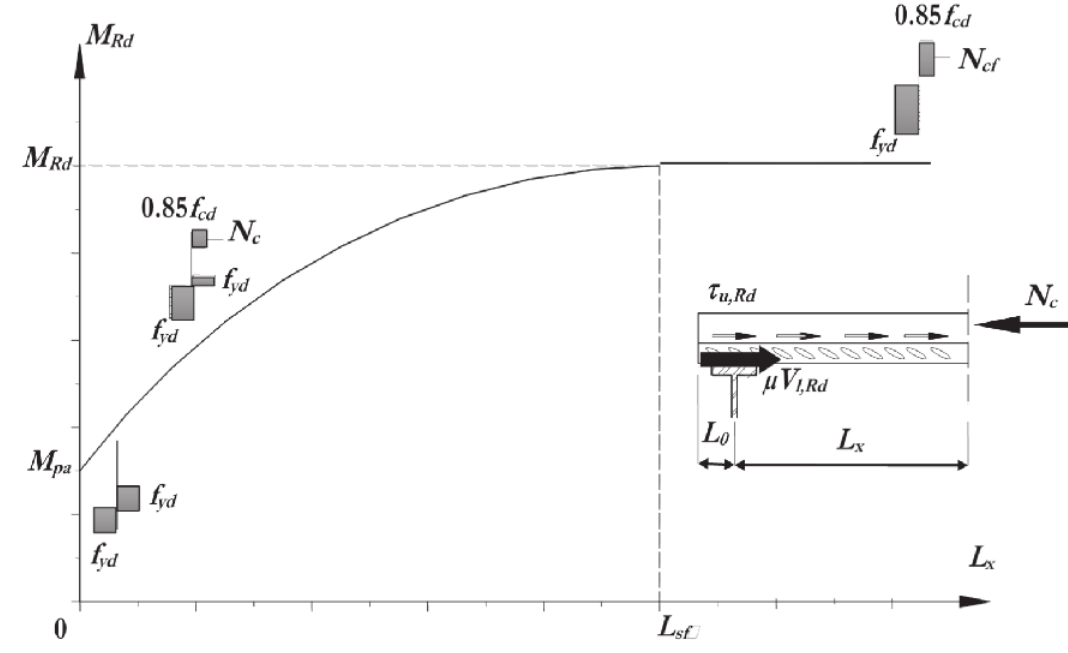
Design partial interaction